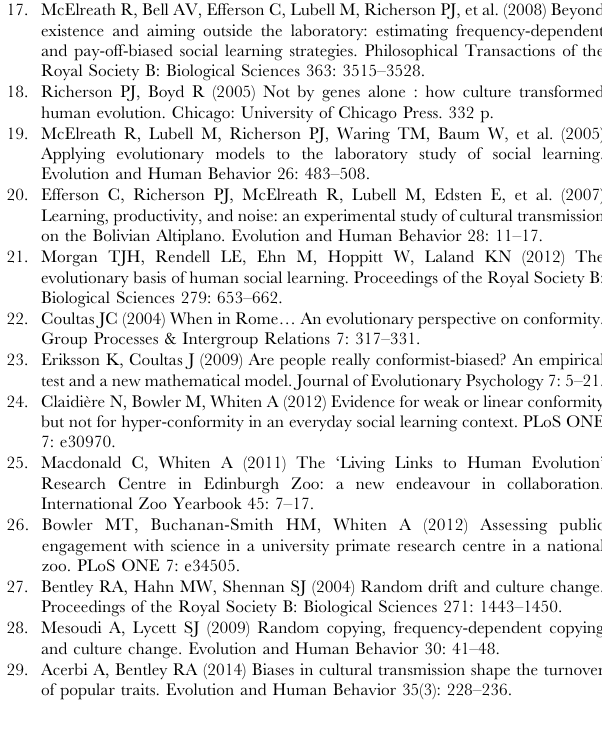
Table S1 Data for the study regarding the robustness of conformity. Quality: represent the four quality conditions: High, Low, Standard (STD) and 2010 (correspond to the results of our previous study). Text Displayed: the five frequency of text put on display (0, 25, 50, 75 and 100%. Session: the order in which the sessions were realized. Text only, Drawing only, Mainly text and Mainly drawing correspond to the four categories described in the main text.